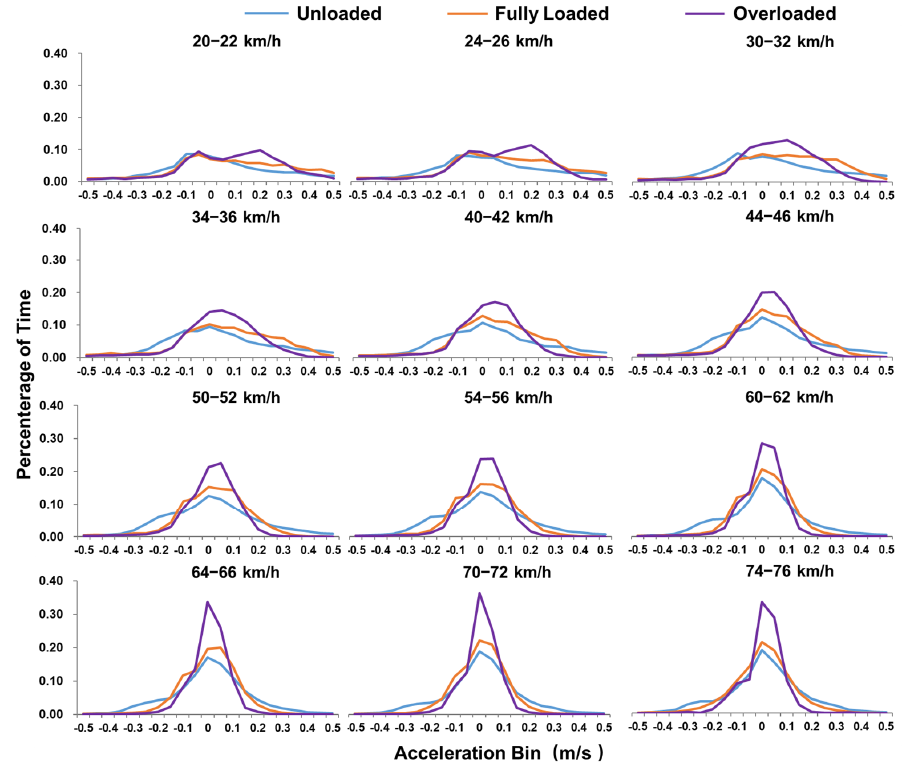
Figure 5. Acceleration distribution for DSTTTs with unloaded, fully loaded and overloaded in different speed bins.